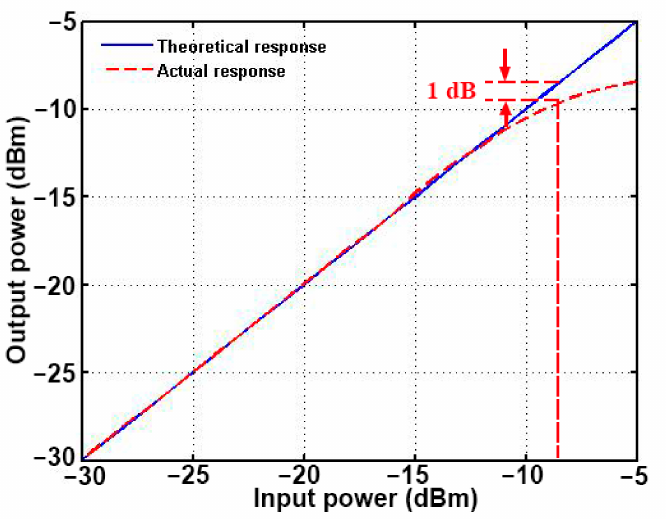
Figure 39. The measured P1dB of the NBPF at V BP5 with the input power when f o was 165.8 kHz.